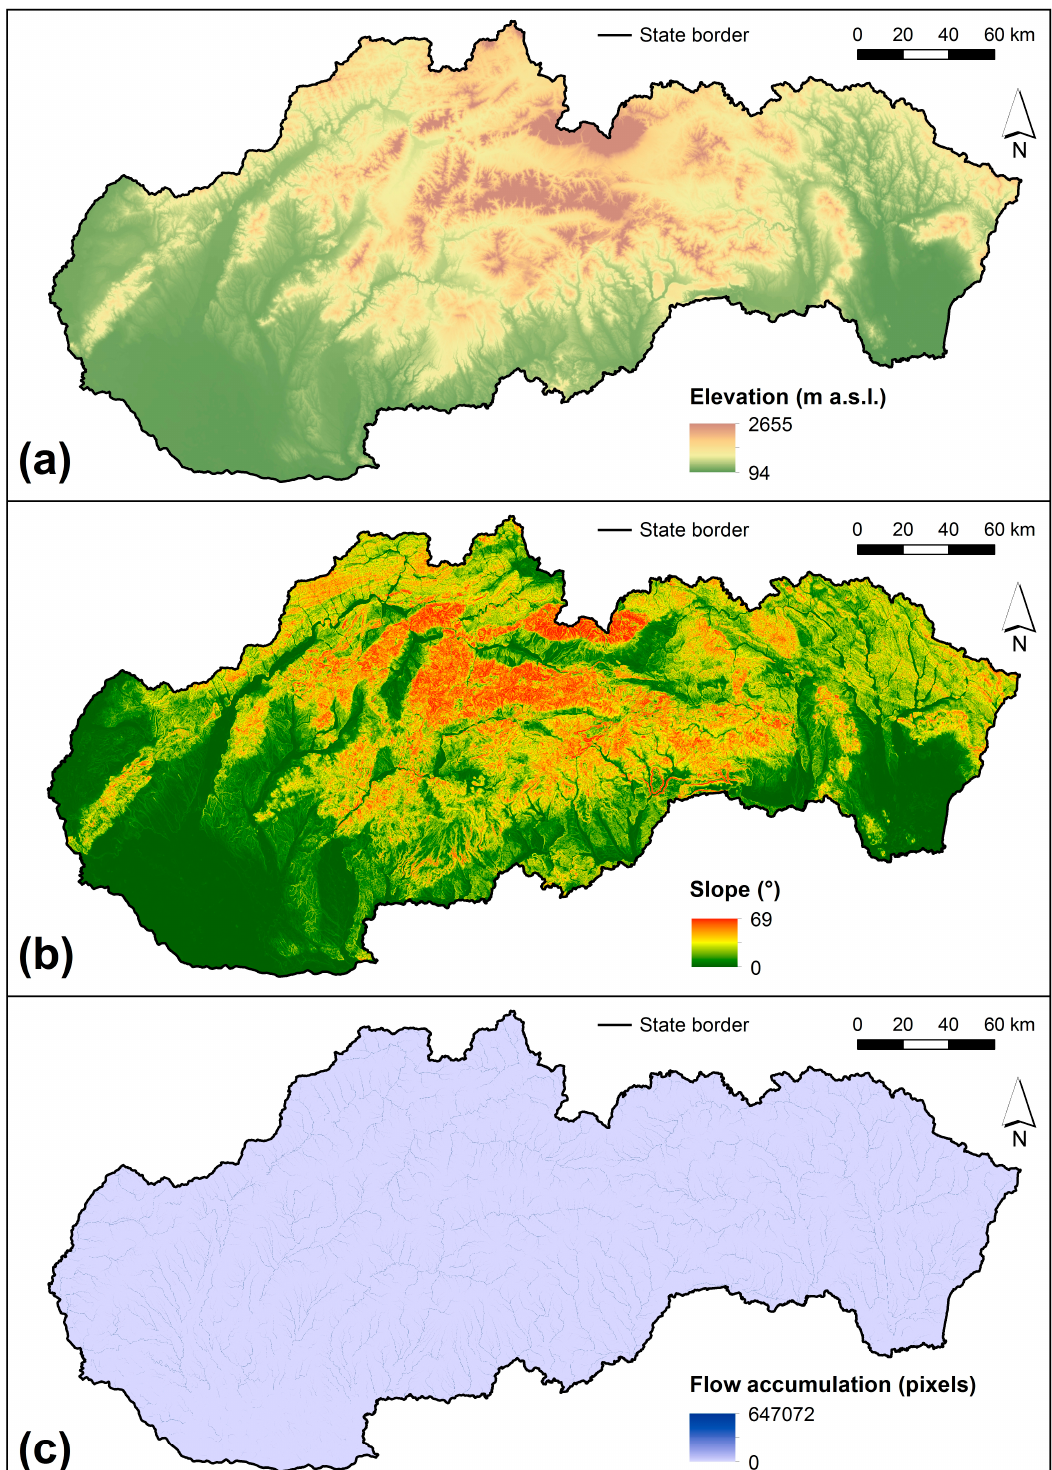
Figure 3. Flood conditioning factors: ( a ) elevation, ( b ) slope, ( c ) flow accumulation.